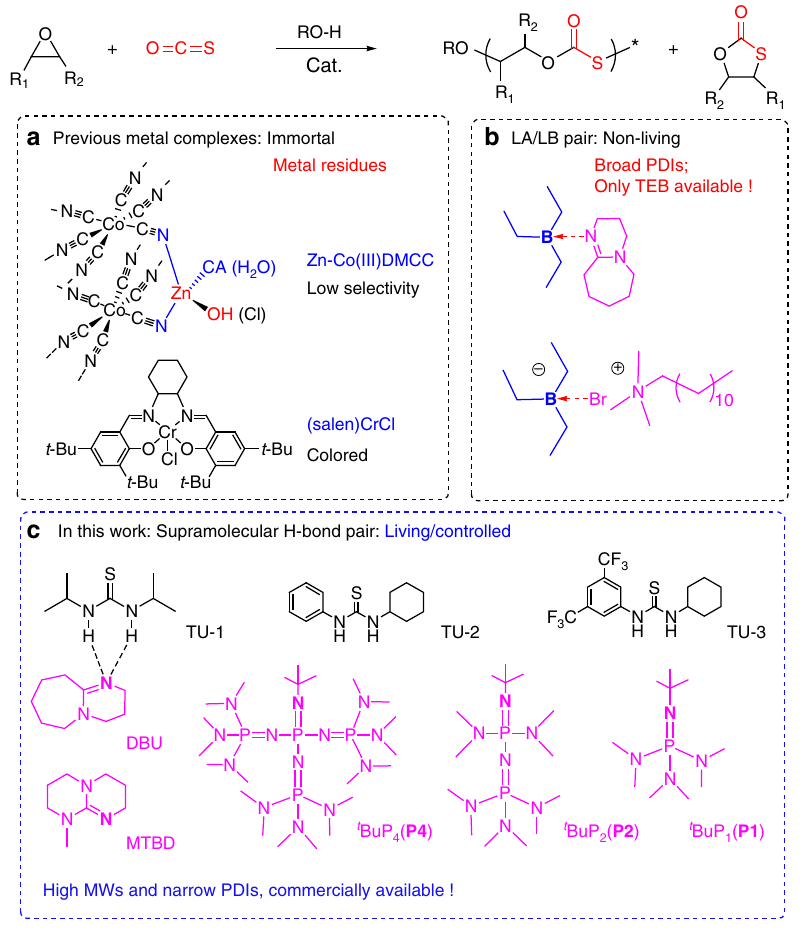
Fig. 1 The catalyst systems for COS/epoxide copolymerization. a Metal catalysts (zinc-cobalt(III) double-metal cyanide complexes and (salen)CrX/onium salts), b TEB/LB pairs (triethylborane/Lewis bases), c TU/base pairs in this study (TU-1: diisopropyl thiourea; TU-2: 1-cyclohexyl-3-phenylthiourea; TU-3: 1-[3,5-bis(tri fl uoromethyl) phenyl]-3-cyclohexylthiourea; DBU: 8-diazabicyclo[5.4.0]undec-7-ene; MTBD: N -methyl-1,5,7-triazabicyclododecene; t Bu-P 4 : P4 , 1- tert -butyl-4,4,4-tris(dimethylamino)-2,2-bis [tris(dimethylamino)- phosphoranylidenamino]-2 λ 5,4 λ 5-catenadi(phosphazene); t Bu-P 2 : P2 , 1- tert - Butyl-2,2,4,4,4-pentakis(dimethylamino)-2 λ 5,4 λ 5-catenadi(phosphazene); and t Bu-P 1 : P1 , tert -butylimino-tris(dimethylamino)